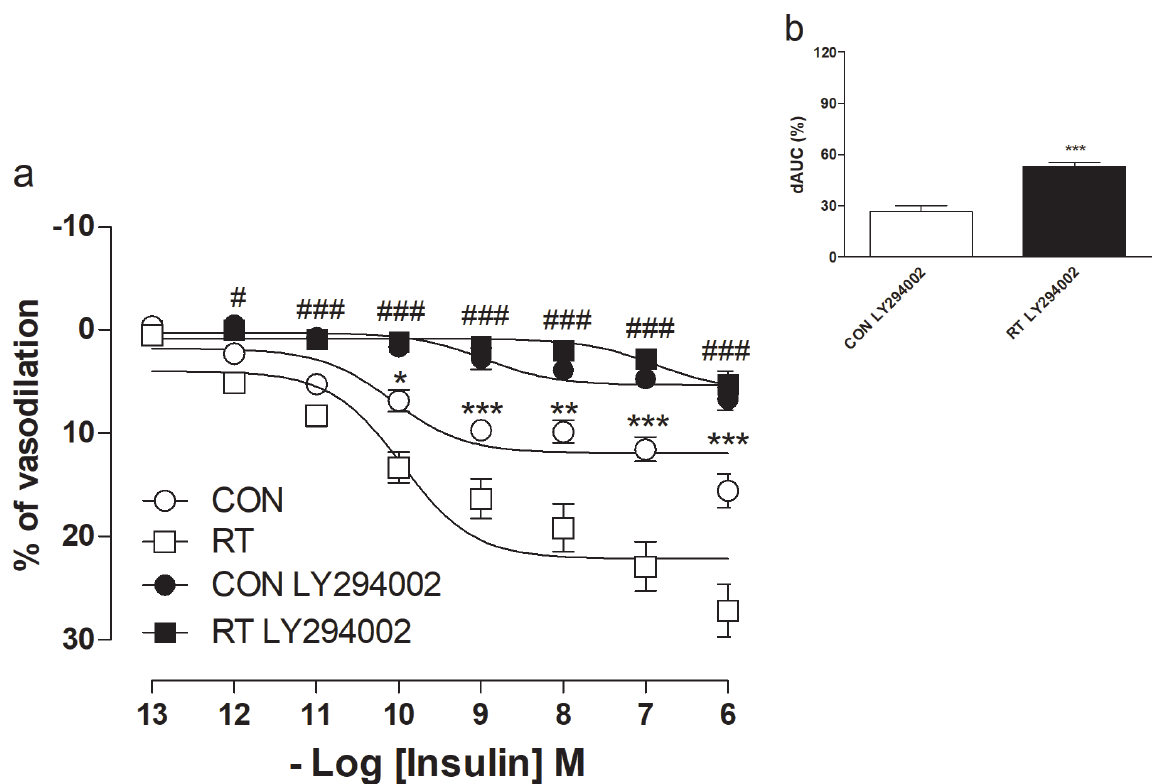
Figure 2. Concentration-response curves for insulin (10 -13 - 10 -6 M) in isolated rings of the rat superior mesenteric artery with functional endothelium and pre-contracted with Phe (1µM). (a) Rings obtained from animals of the Control group (CON) and Resistance training (RT) in the absence and presence of LY294002 (50µM). (b) Variation of the area under the curve (dAUC) between the presence and absence of LY294002. The data represent the mean ± SEM for 8 - 10 experiments for each group. (a): * p < 0.05, ** p < 0.01, *** p < 0.001, CON vs CON LY294002. # p < 0.05, ### p < 0.001, RT vs. RT LY294002; (b): *** p < 0.001 CON LY294002 vs. RT